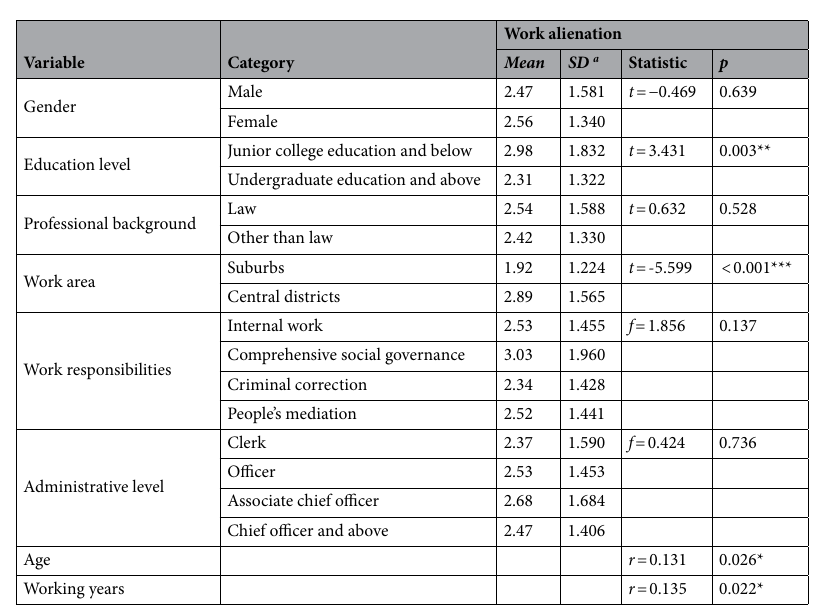
Table 3. One-way variance/correlation analysis of work alienation. * p < 0.05,** p < 0.01, *** p ≤ 0.001; a. SD = standard